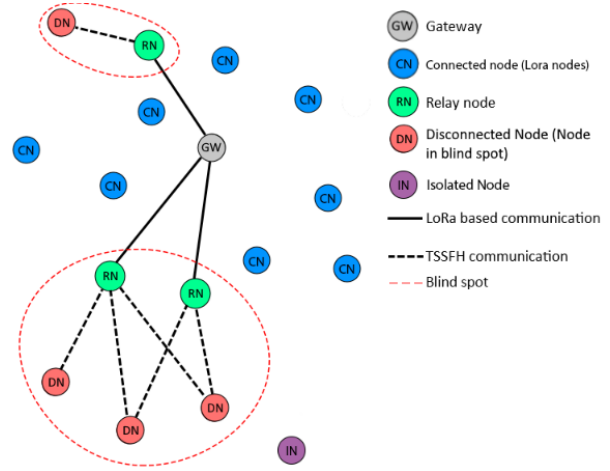
Figure 1. TSSFH complementing a LoRa-based network to mitigate blind spots.